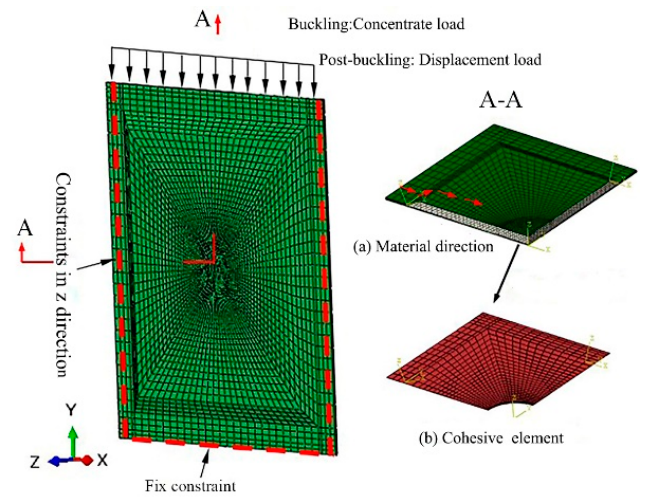
Figure 14. The grid discretization and boundary conditions of the debonding model.